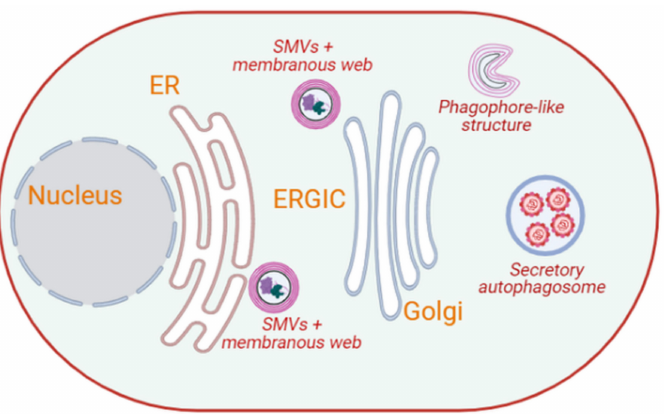
Figure 2. Intracellular membrane rearrangements induced by picornaviruses. Picornaviruses, such as poliovirus and CVB3, induce the formation of SMVs that contain non-structural proteins and dsRNA, and are embedded in a membranous web located adjacent to the ER. Over the course of the infection, these membranous webs relocalize near the Golgi, where crescent-shaped phagophore-like structures emerge from them. These phagophore-like structures may serve as the precursors to double-membrane autophagosomes, which appear approximately 6 hr post-infection. Complete picornaviral particles appear to exit cells using secretory autophagy. (Image created in